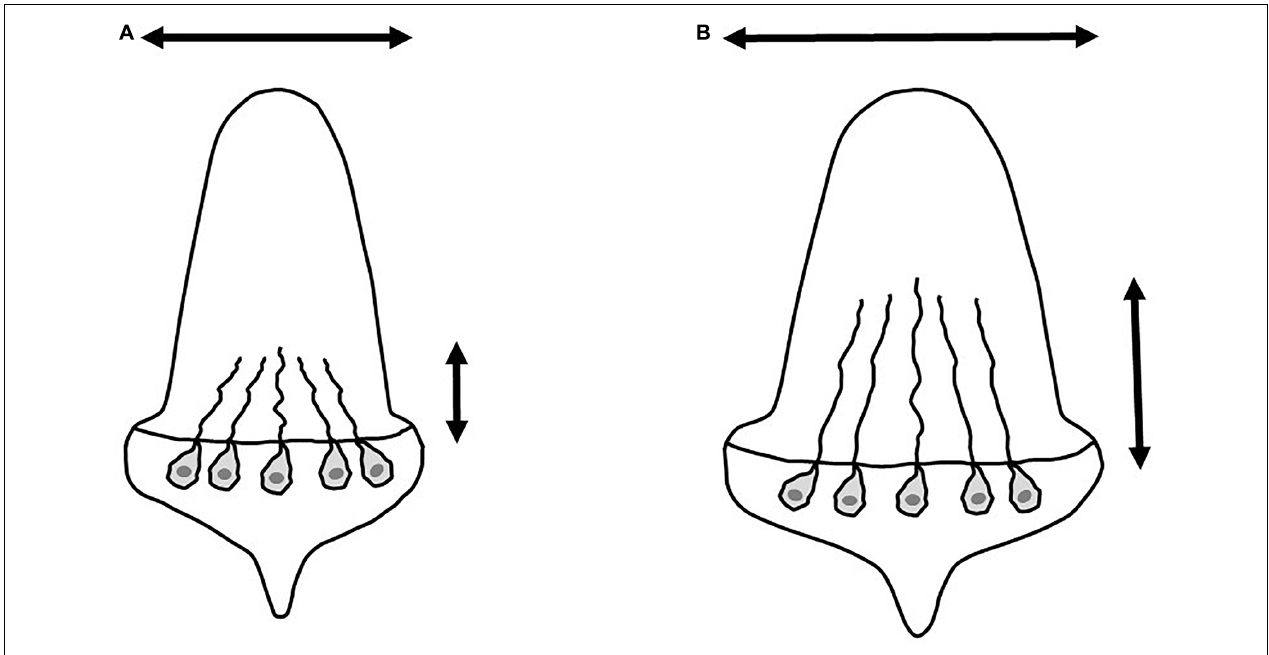
FIGURE 4 | Expected morphological differences in fishes’ neuromasts under acidic and neutral/alkaline environments according to Lin et al. (2019). (A) Fishes under acidic environments may show short hair bundles and the apical area of the neuromasts shortened. (B) On the other hand, fishes from neutral/alkaline aquatic environments may show longer hair bundles and larger apical area of the neuromasts. Arrows mark the expected differences in neuromasts